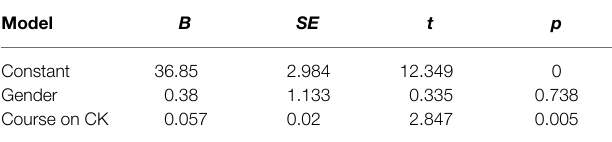
TABLE 6 | Results of multiple regression analyses with CK as criterion. Model